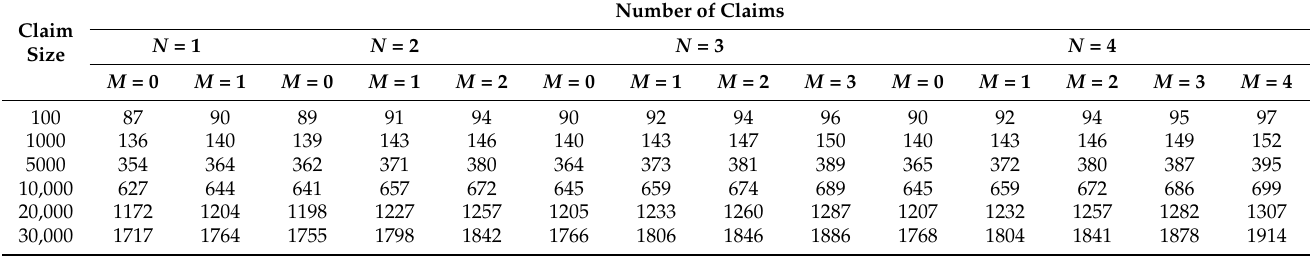
Table 11 are depicted in Figure 6. Premiums were dependent on aggregate claim amount,